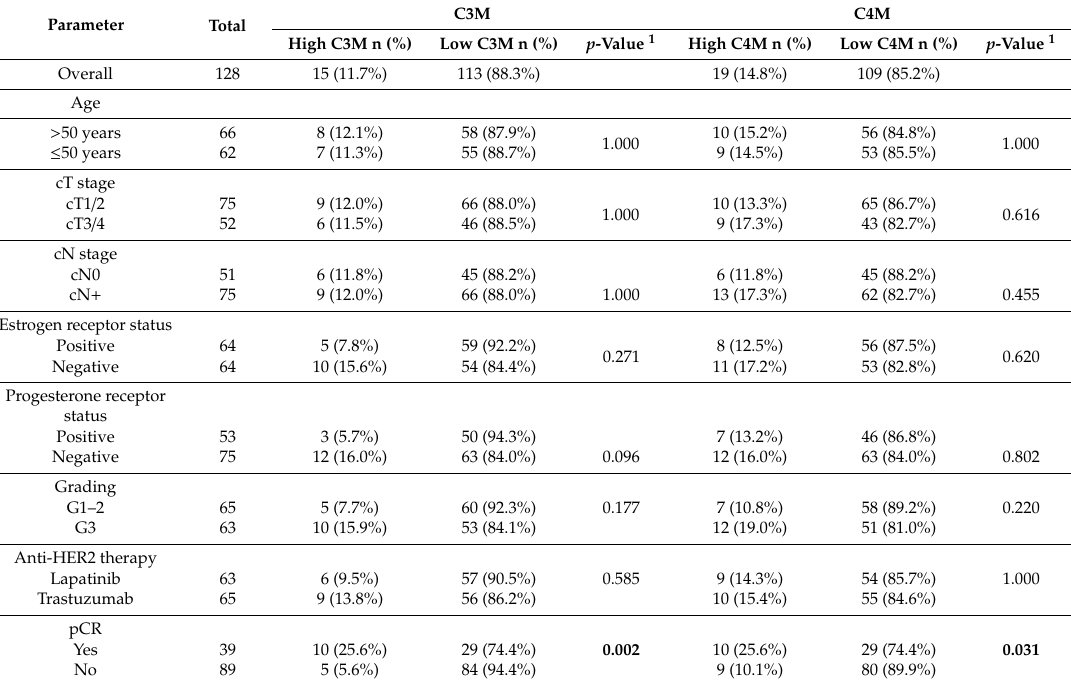
Table 1. Correlation between collagen degradation marker levels in the serum at baseline and clinical-pathological, treatment and outcome